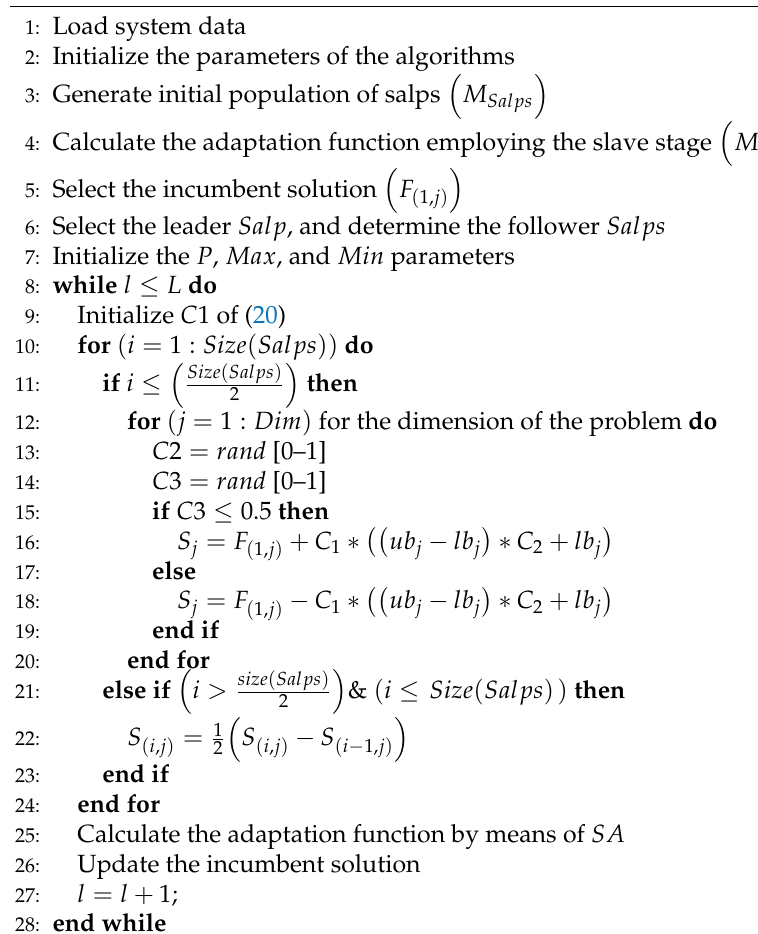
Algorithm 1 SSA optimization